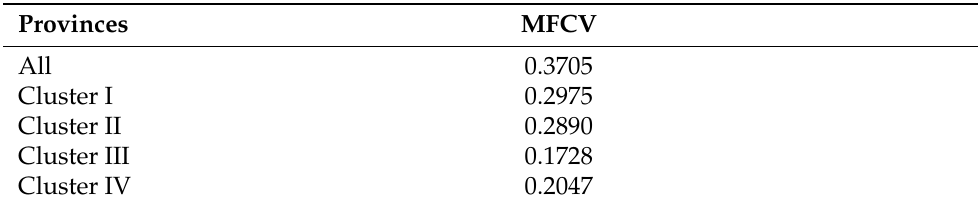
Table 7. Values of the multivariate functional coefficient of variation